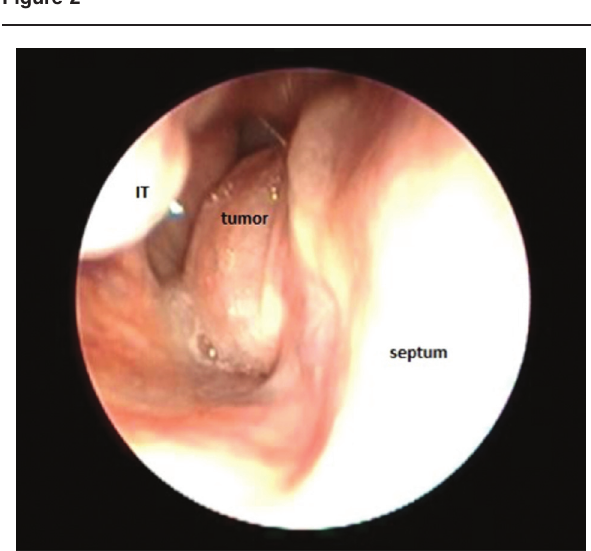
The tumor completely occludes the posterior nasal cavity.